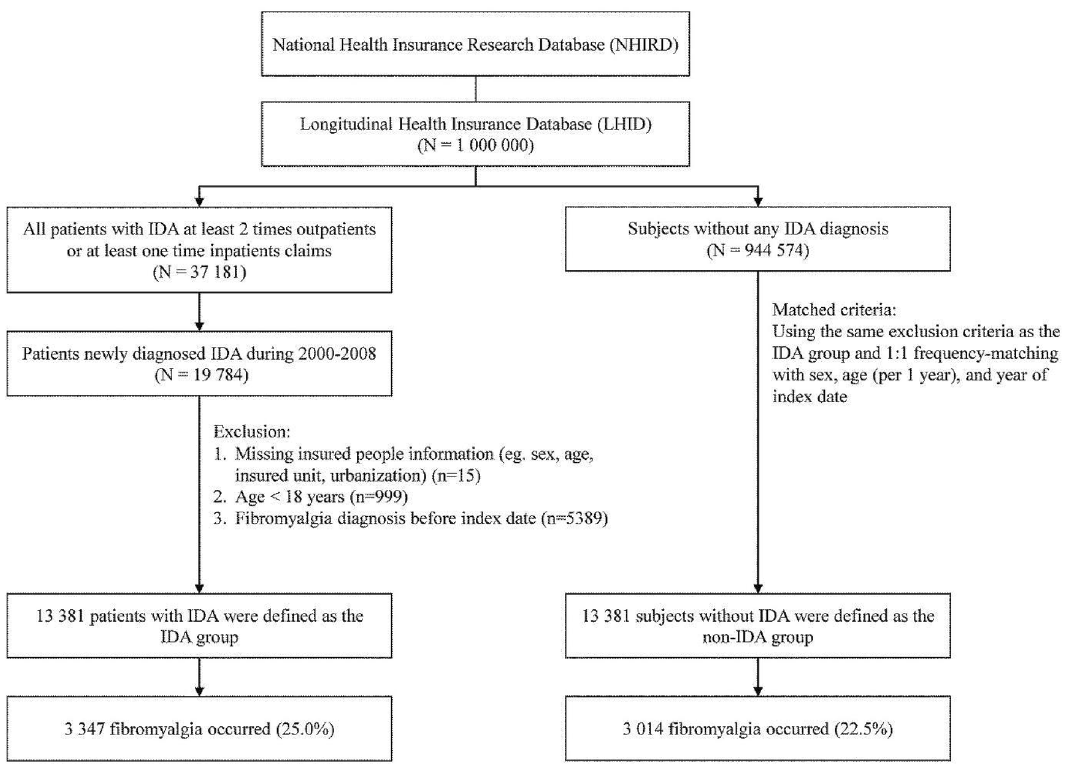
Figure 1. The selection process of the participants in the cohort study. Abbreviation: IDA, iron deficiency